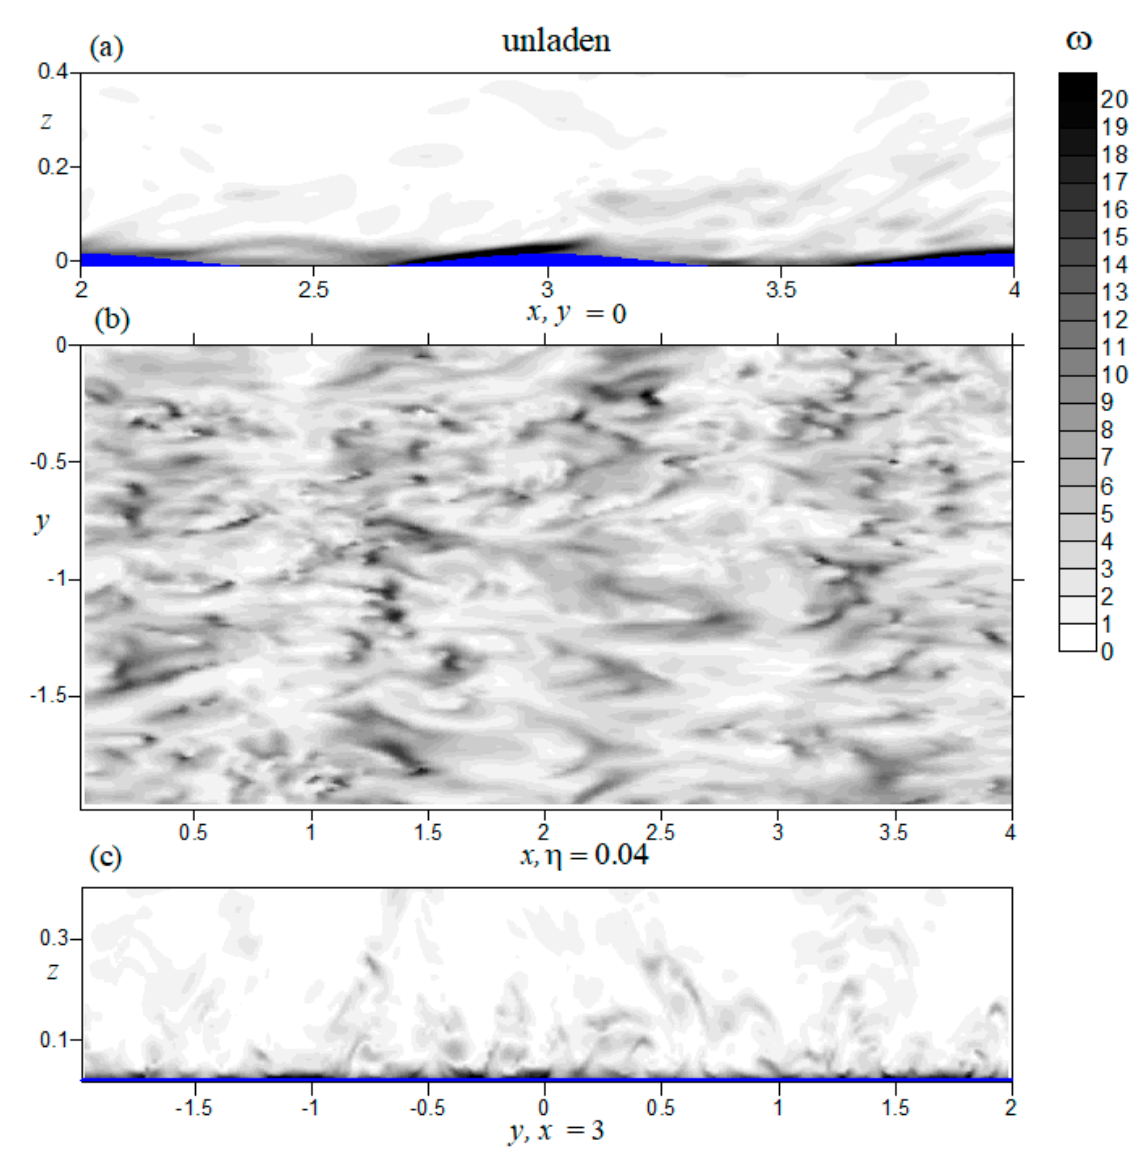
Figure 2. Instantaneous distribution of the vorticity modus, ω , obtained in central ( x , z ) ( a ) and ( y , z ) ( c ) planes and in a near-surface ( x , y ) plane at η = 0.04 ( b ) in DNS with ka = 0.1 in the unladen flow case. Here and below in Figures 3 and 4, only part of the total domain is shown in panels ( a , b ).